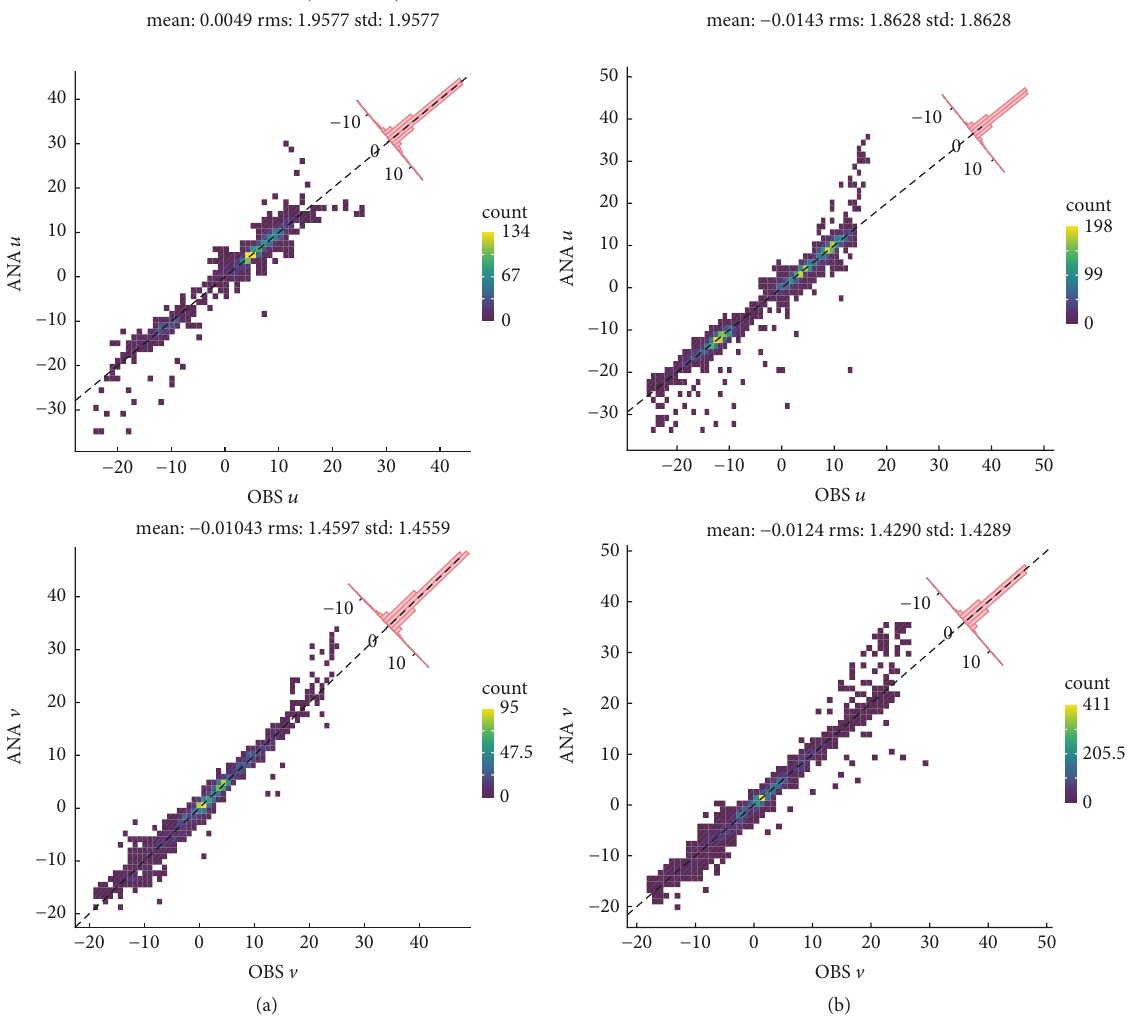
Figure 5: O / A comparison of the bias, root-mean-square value, and standard derivation of the 𝑢 and V wind components: (a) superobbing with regular box; (b) superobbing with feature